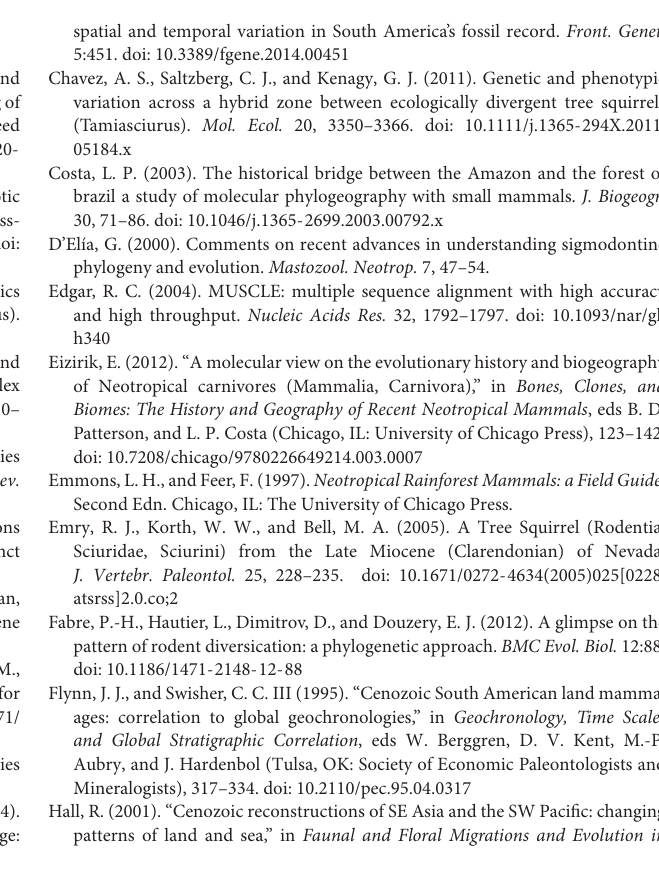
FIGURE S2 | Bayesian maximum clade credibility chronogram based on 13 mitochondrial protein-coding genes (11,278 bp) of 43 species of Sciurini and two species of Pteromyini used as outgroup. The mean heights along with the 95% highest posterior density intervals of dates are shown at each node. FIGURE S3 | Chronogram employed on the range evolution estimation of the tribe Sciurini on a global scale, showing the numbers of the nodes. FIGURE S4 | The most probable biogeographical scenario for Sciurini based on the set of ancestral ranges that received the highest likelihood in the global scale analysis, as inferred by DEC + J model. Colors in key boxes and map correspond to coloring of boxes within the tree (most probable ancestral ranges) and at terminals (current distribution of species).